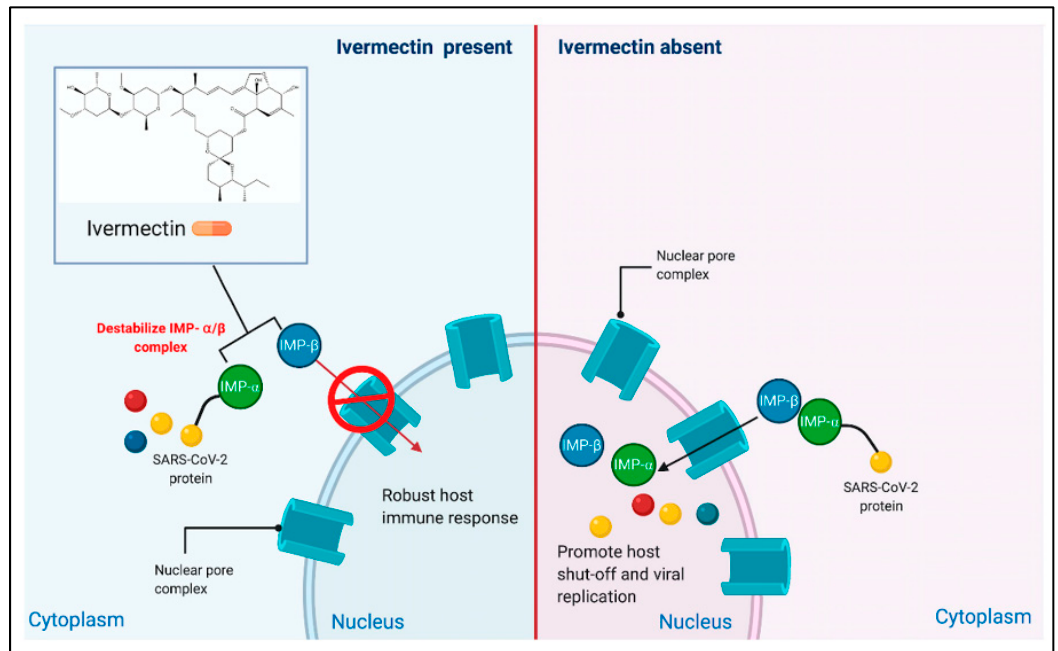
Figure 2. Potential antiviral action of IVM inhibiting IMP α / β 1-mediated nuclear import of viral proteins of SARS-CoV-2. Figure adapted from reference [26] (CC BY 4.0).